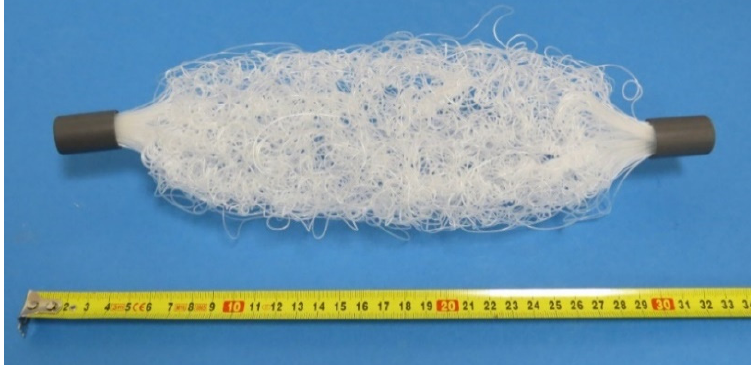
Figure 1. An electron microscope image of the porous polypropylene membrane that was used for distillation; the photograph was provided by ZENA s.r.o. [27].